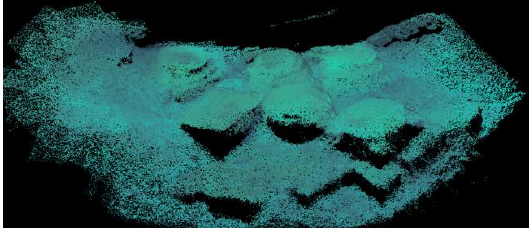
Figure 12. Lipari after global registration (2)